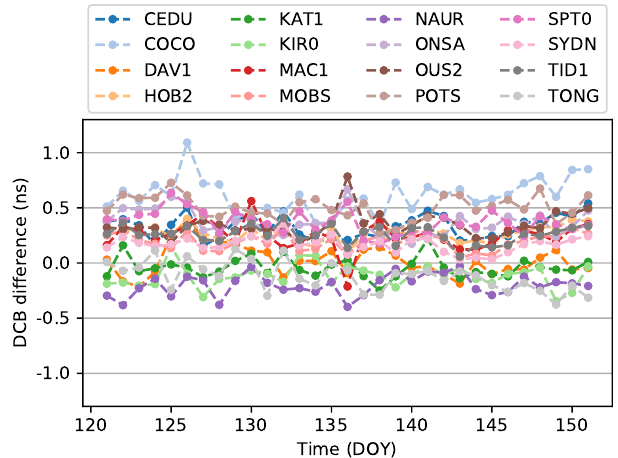
Figure 2. DCB difference from the CODE values in May